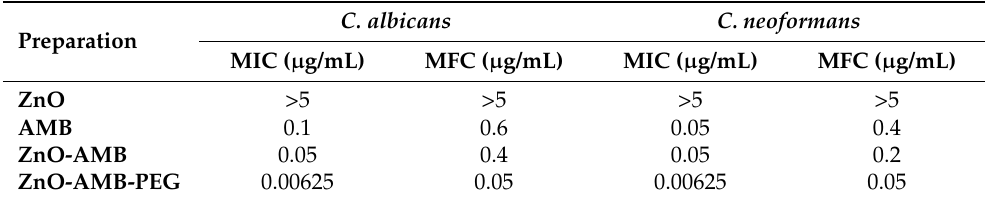
Figure 4. EDX spectrum of ZnO-AMB-PEG sample.